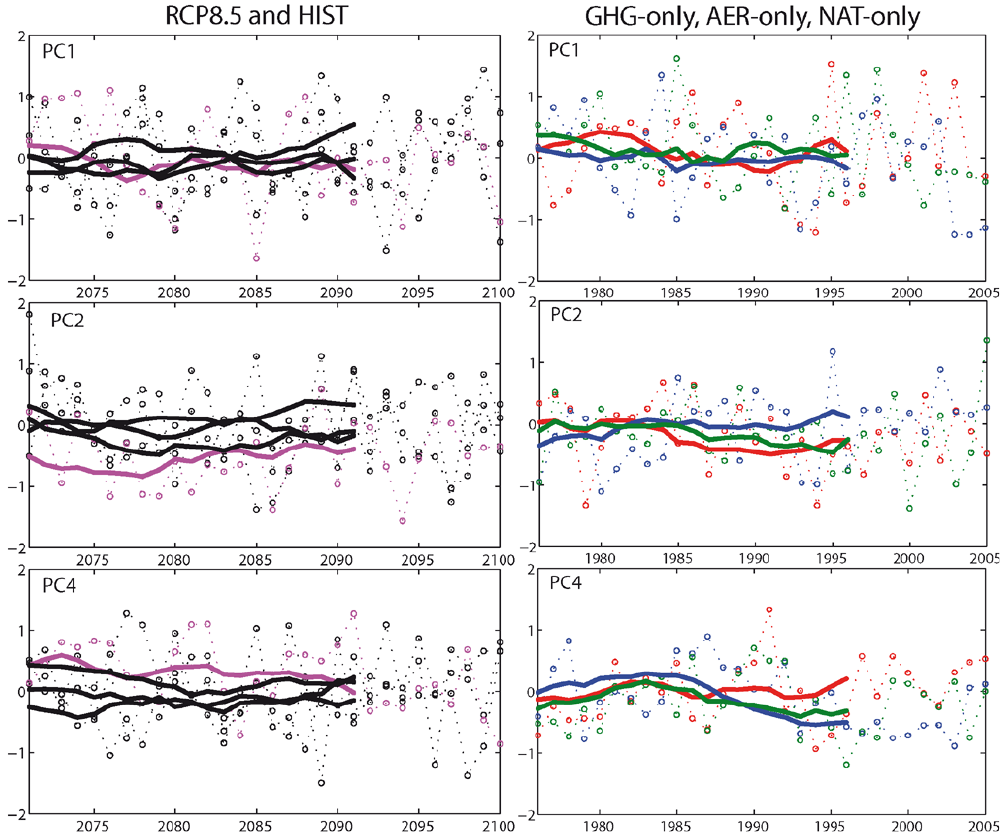
Fig. 15. The left column shows components of the non-detrended geopotential height anomalies for each 4-month season (DJFM) of the 3 historical ensemble members for 1976–2005 (black dashed lines and circles), and for the simulated climate projection for each 4-month season of the years 2071–2100 (denoted on the x-axes) using the RCP8.5 scenario with NorESM1-M (magenta dashed lines and circles). Thick lines are 10-yr forward moving averages. Right column shows similar components for the experiments with GHG-only (red), Aerosol- only (blue), and Natural forcing only (green) for